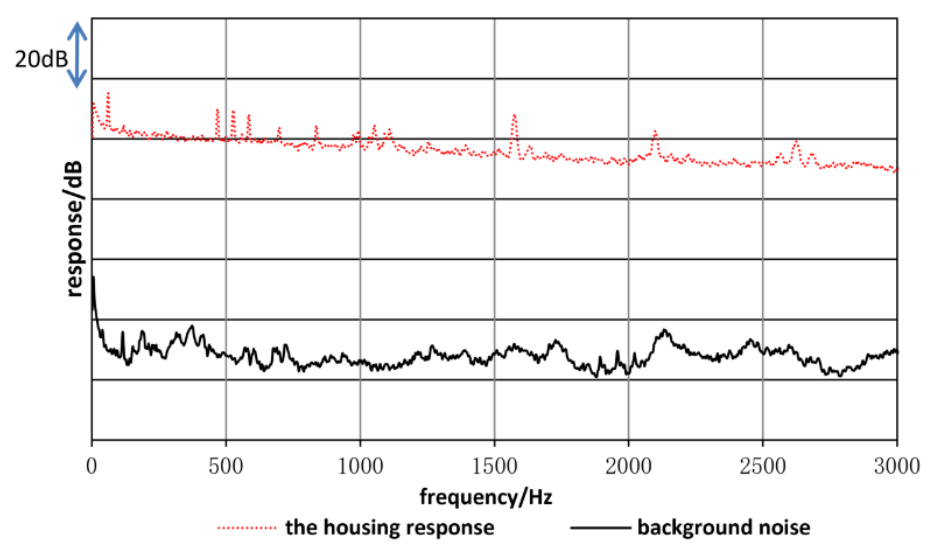
Figure 4. Signal-to-noise ratio of the housing vibration response.